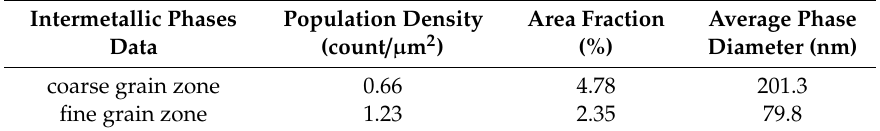
Table 1. Statistical data of intermetallic phases in coarse and fine grain zones in sintered alloy.